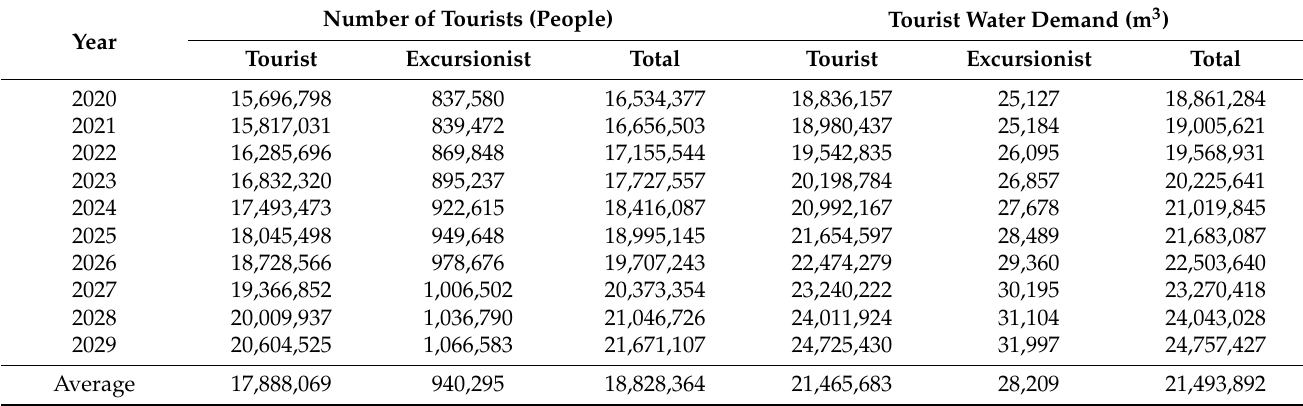
Table 21. The number of tourists and water demand between 2020 and 2029 under normal